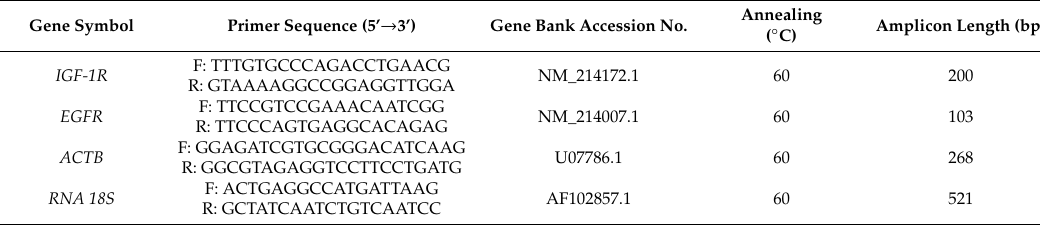
Table 1. Used primer sequences.